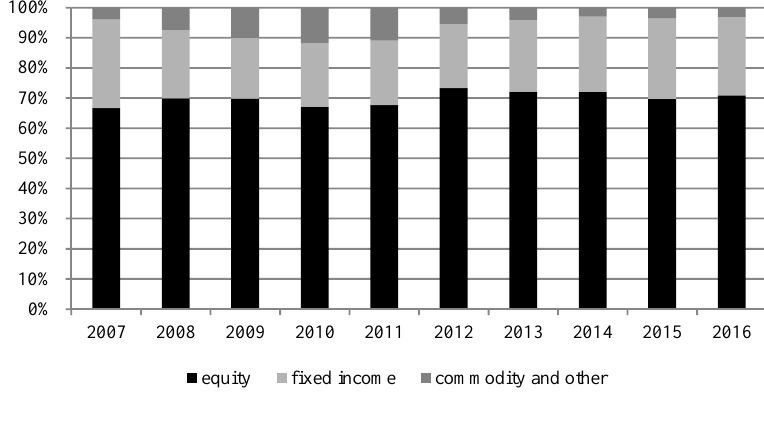
Source: own calculations based on data extracted from the Lipper’s database. Figure 3. Structure of the European exchange-traded products market in terms of asset classes (classified according to assets under management) between 2007 and